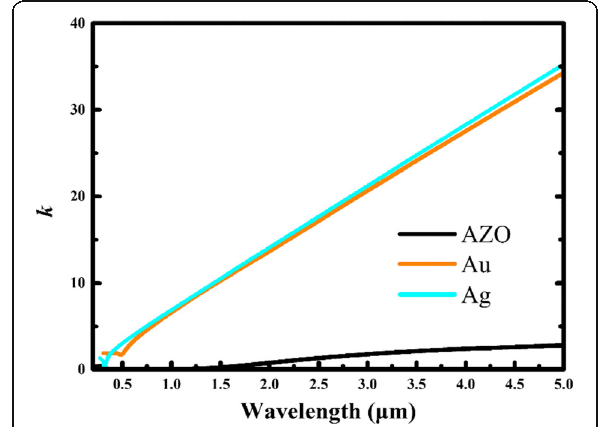
Fig. 6 Extinction coefficient k of AZO, Au, and Ag ranges from 0.2 to 5.0 μ m [33,